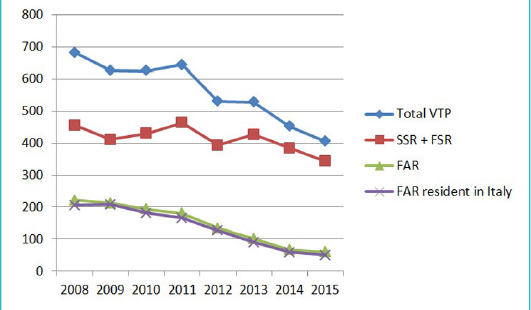
Figure 1: Number of abortions from 2008 to 2015 for women resi- dent in Switzerland (SSR + FSR), foreign women resident abroad (FAR) and foreign women resident in